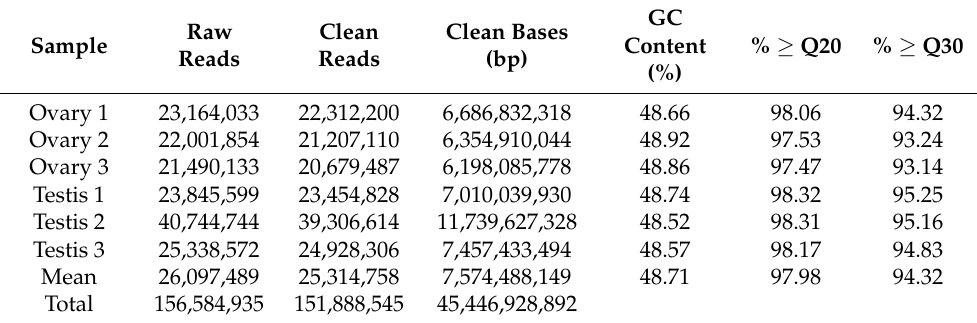
Table 1. Summary statistics of the gonadal RNA-Seq data for D. hystrix .